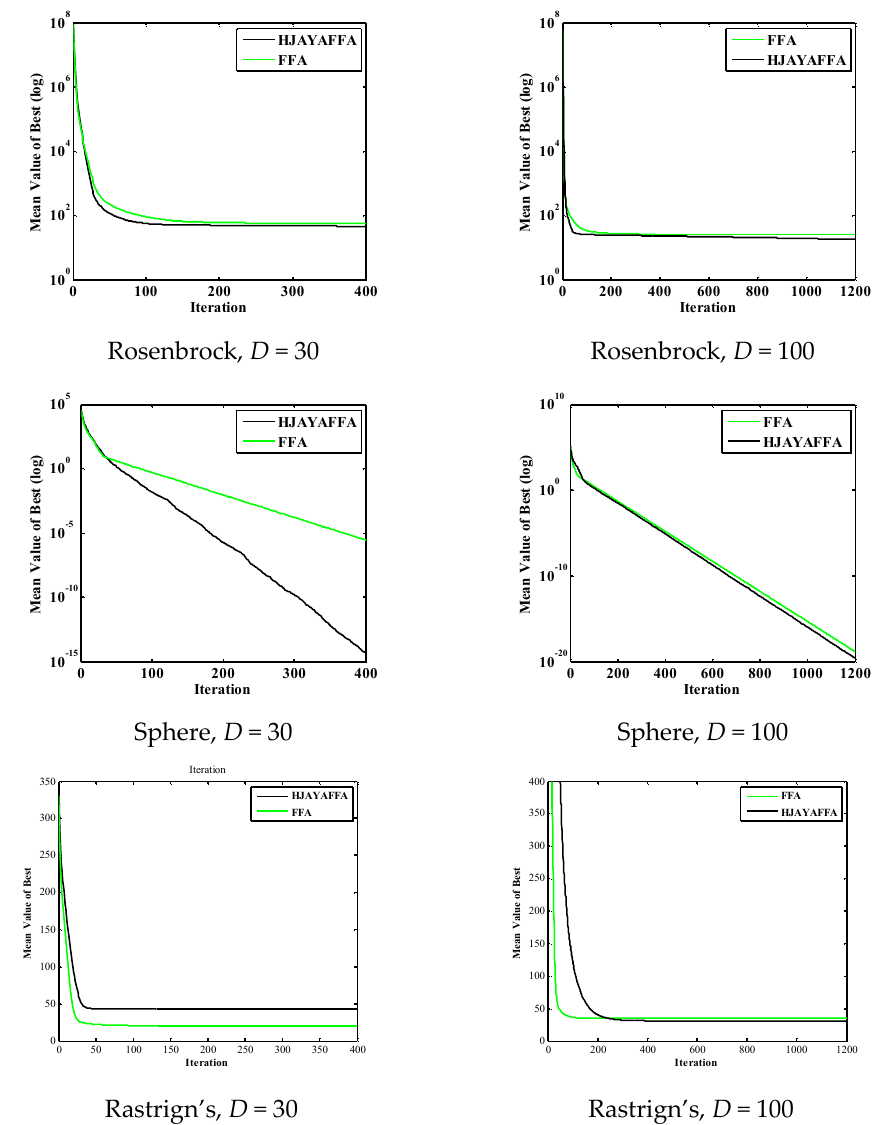
Figure 3. Convergence of some optimization test functions by the proposed algorithm.